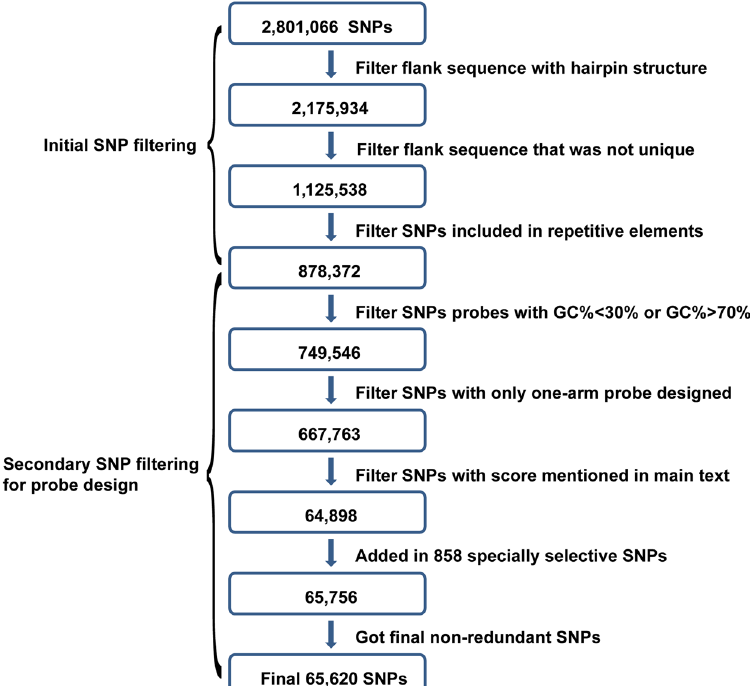
Figure 2. SNP selection and probe design workflow for the 66 K SNP chip.